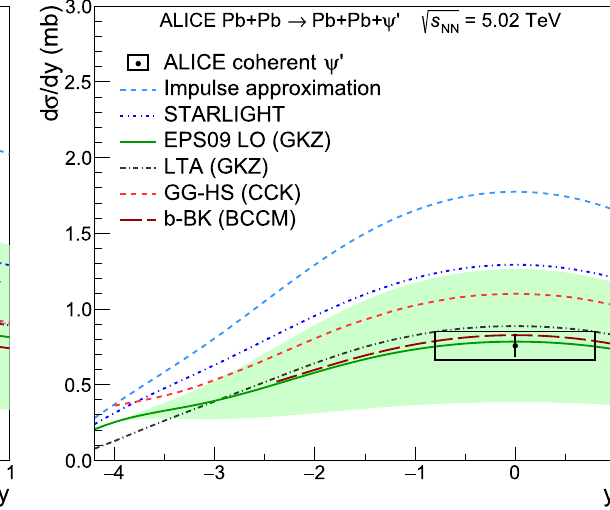
calculationsarealsoshown.Thegreenbandrepresentstheuncertainties of the EPS09 LO